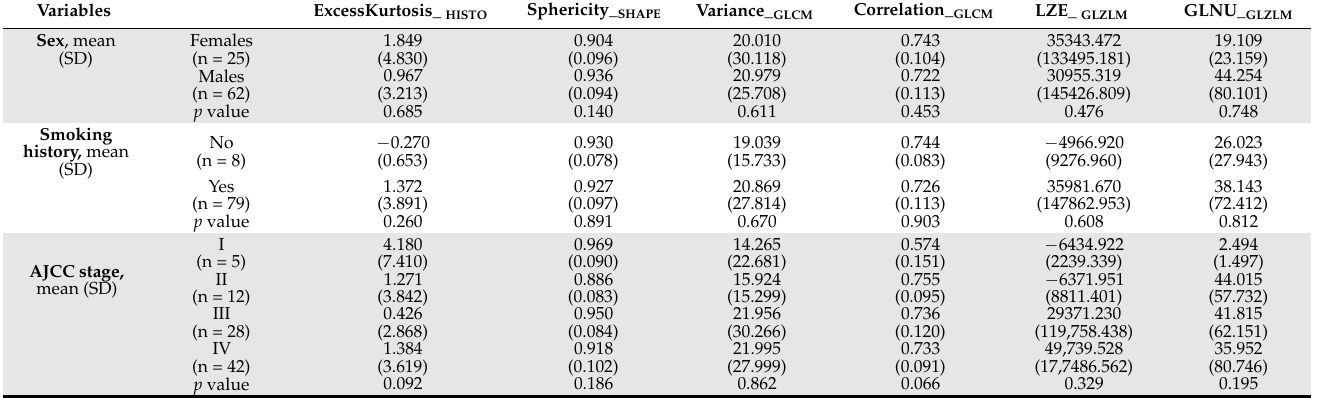
Table 4. Comparisons of positron emission tomography variables of interest according to sex, smoking history, and stage according to American Joint Committee on